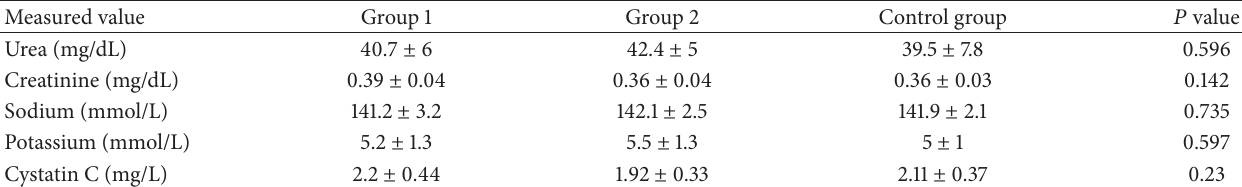
Table 1: Comparison of renal function tests between the groups (plasma